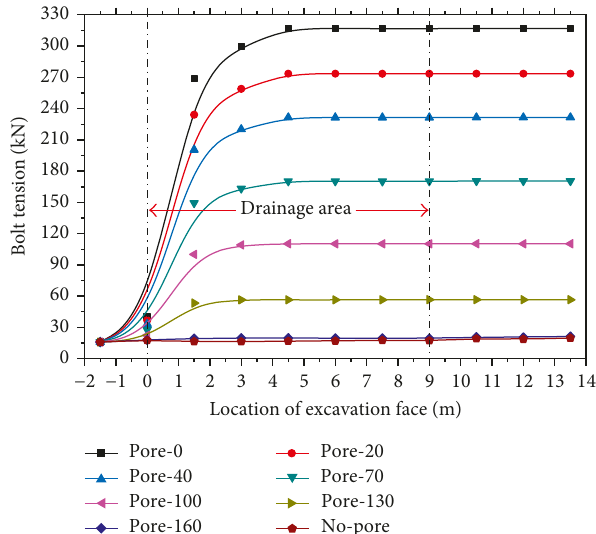
Figure 20: The maximum tension force of